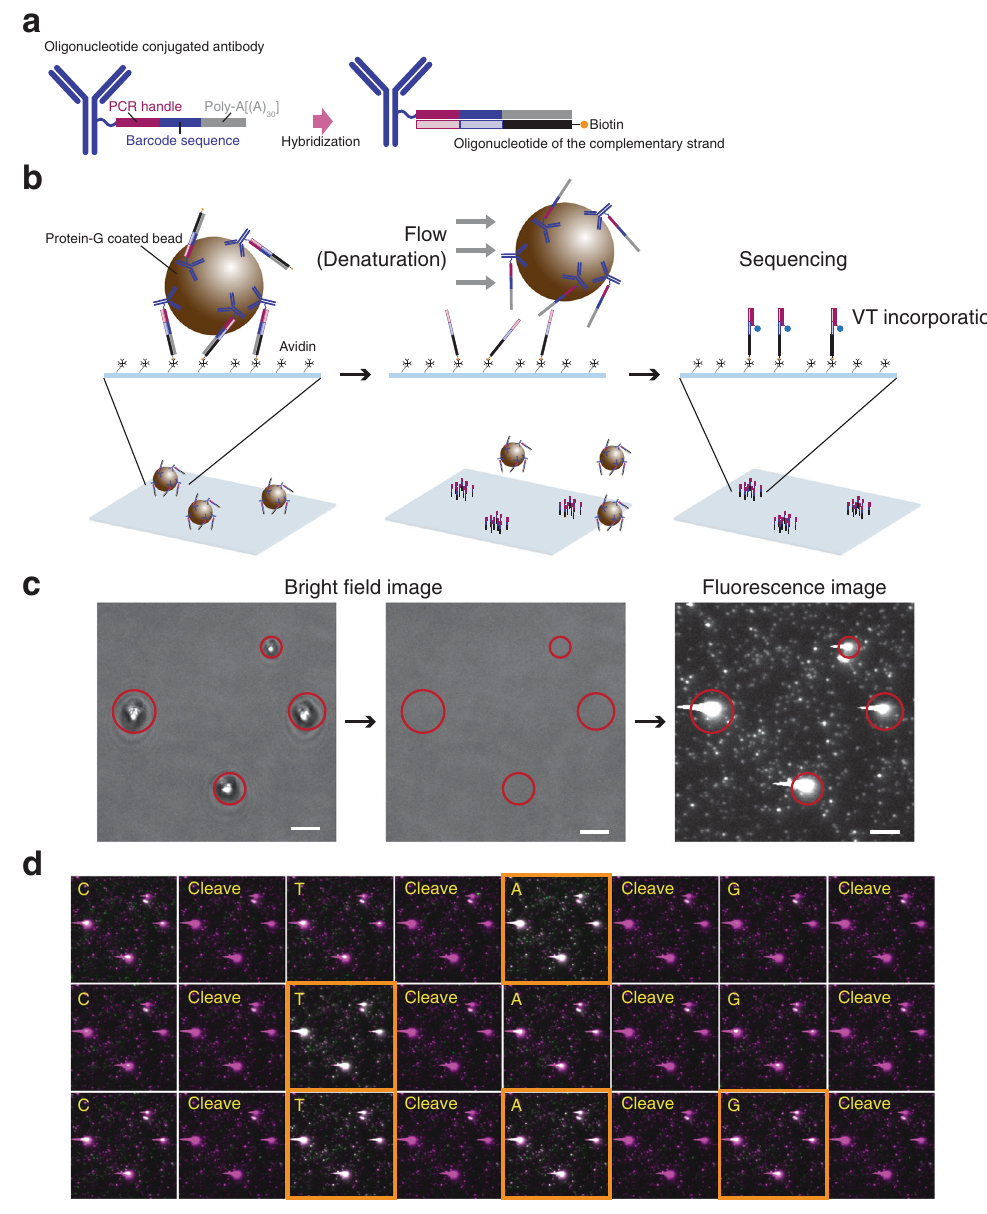
Fig. 5 A proof of concept experiment for molecular foot printing. a Ab-barcode complex with a pre-synthesized oligonucleotide of the complementary strand. Barcode-strand was double-stranded with an oligonucleotide of the complementary sequence of the barcode instead of reverse transcription. b Schematic illustration of the experiment. Protein-G coated magnetic beads binding with the double-stranded Ab-barcode were introduced into a sequencing fl ow cell and captured on the surface via biotin-avidin interactions (left). After observing the beads, they were washed from the fl ow cell via a pressure driven fl ow of 50% formamide solution, while the complementary sequences remained on the surface (middle). Visualization of the complementary sequences remained on the surface by incorporating VTs (right). c Microscopic images corresponding to the schematic illustration shown in b . Blight fi led images of protein-G coated beads on the surface (encircled in red, left panel). After washing, the beads were con fi rmed to have moved from the original position (middle). Fluorescence image of the complementary sequences remained on the surface visualized by VT incorporations (right panel). Scale bars shown in c indicate 5 µ m. d Overlaid images of each cycle (green) on the image of the 1st cycle (magenta). Rectangles in orange indicate expected cycles of VT incorporation according to the barcode sequence. Sequencing proceeded from left to right (CTAG) and top to bottom (1Q to 3Q) in this sequential